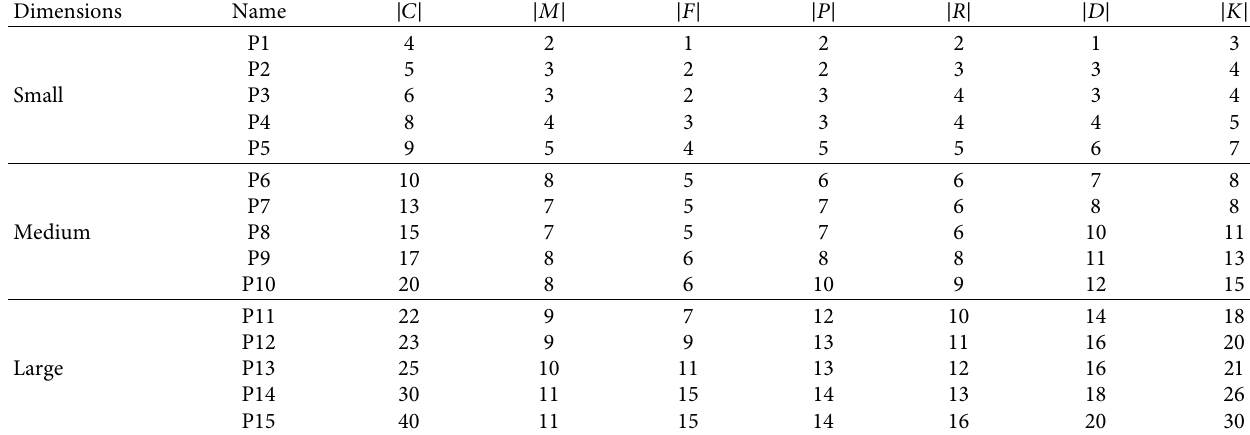
Table 7: Dimensions of design numerical examples.